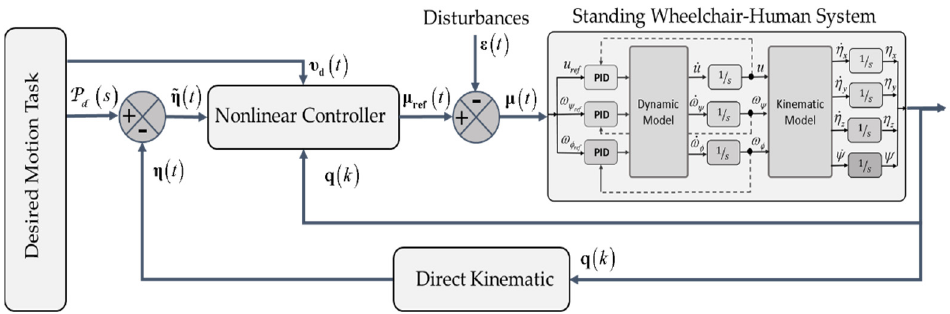
Figure 14. Block diagram of the motion control of the standing wheelchair-human system. The proposed controller considers the saturation of the µ min < µ ref ( t ) < µ max velocity commands, and receives as input signals P ( s ) | s ∈ [ s 0 , s f ] , which describe the desired motion task of the standing wheelchair, respective to the inertial frame R ( X , Y , Z ) . The problem of control to deal with—often called the inverse kinematics problem—is finding the control vector of maneuverability µ ref ( t ) | t ∈ [ t 0 , t f ] . to achieve the desired operational motion. The corresponding evolution of the whole system is given by the actual generalized motion q ( t ) | t ∈ [ t 0 , t f ] . Hence, the control error is defined as (cid:101) η ( t ) = P d ( s ) − η ( t ) , and ( t ) = 0 ∈ R m . The desired velocity of consequently, the control aim is expressed as lim (cid:101) η t → ∞ the standing wheelchair will depend on the task, the control error, the angular velocity,